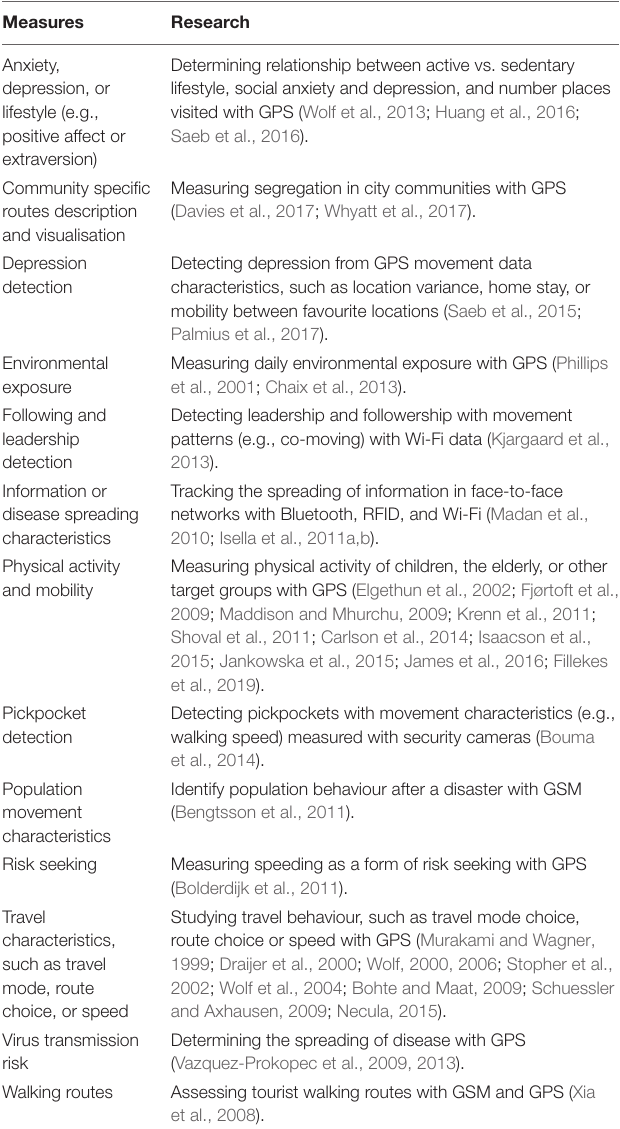
TABLE 1 | Positioning technologies and their use in past